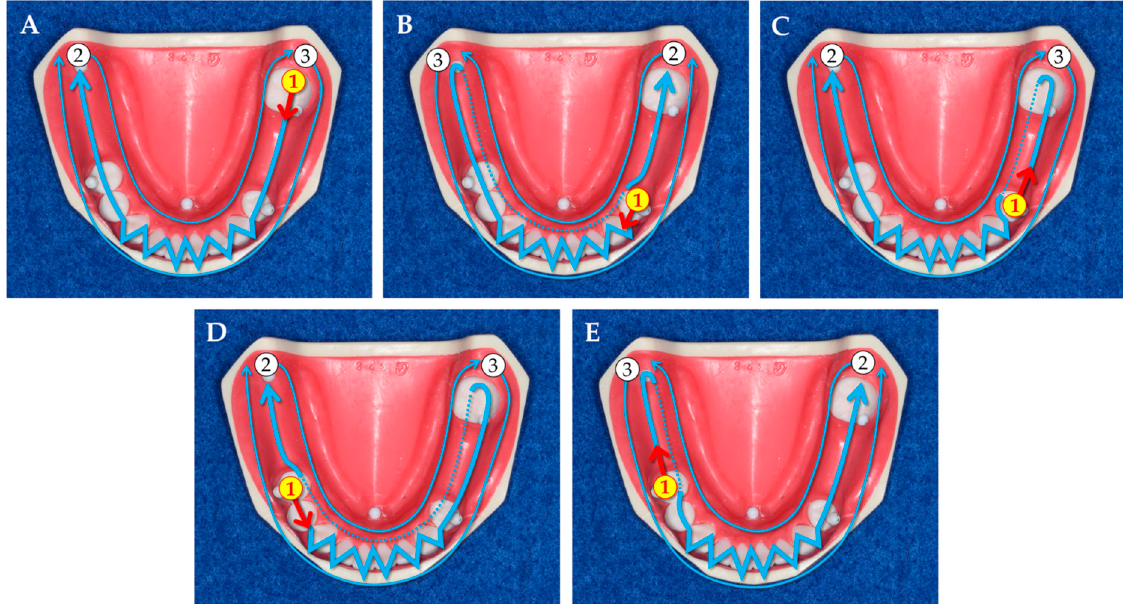
Figure 1. Scanning strategies used in this study. Each strategy basically starts with a route on the occlusal surface (1), followed by a route on the lingual surface (2), and then on the buccal surface (3). Based on the location of the scanning origin and scanning direction from the scanning origin, scanning strategies were defined as follows: ( A ) scanning strategy initiated at #37 and headed to the mesial direction (specified by the manufacturer): 37M; ( B ) scanning strategy initiated at #34 and headed to the mesial direction: 34M; ( C ) scanning strategy initiated at #34 and headed to the distal direction: 34D; ( D ) scanning strategy initiated at #45 and headed to the mesial direction: 45M; and ( E ) scanning strategy initiated at #45 and headed to the distal direction: